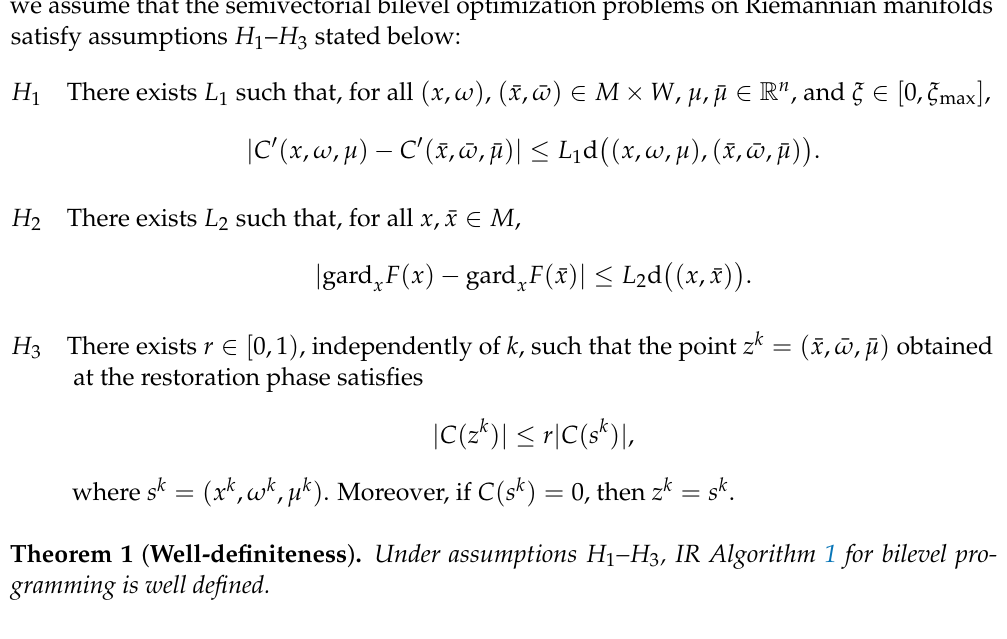
Algorithm 1: Inexact Restoration